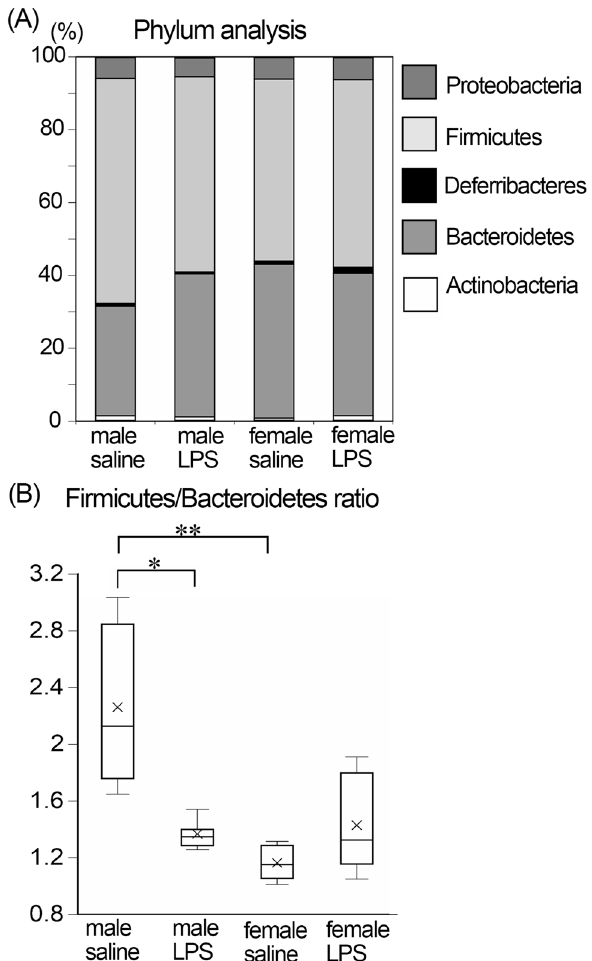
Figure 2. Phylum level analysis of gut microbiota. ( A ) The relative abundance of gut microbiota at phylum level. ( B ) The relative ratio of Firmicutes/Bacteroidetes in gut microbiota. The ratio significantly decreased in male LPS-treated compared to male saline-treated mice. * p < 0.05, ** p < 0.01. n = 5 for each